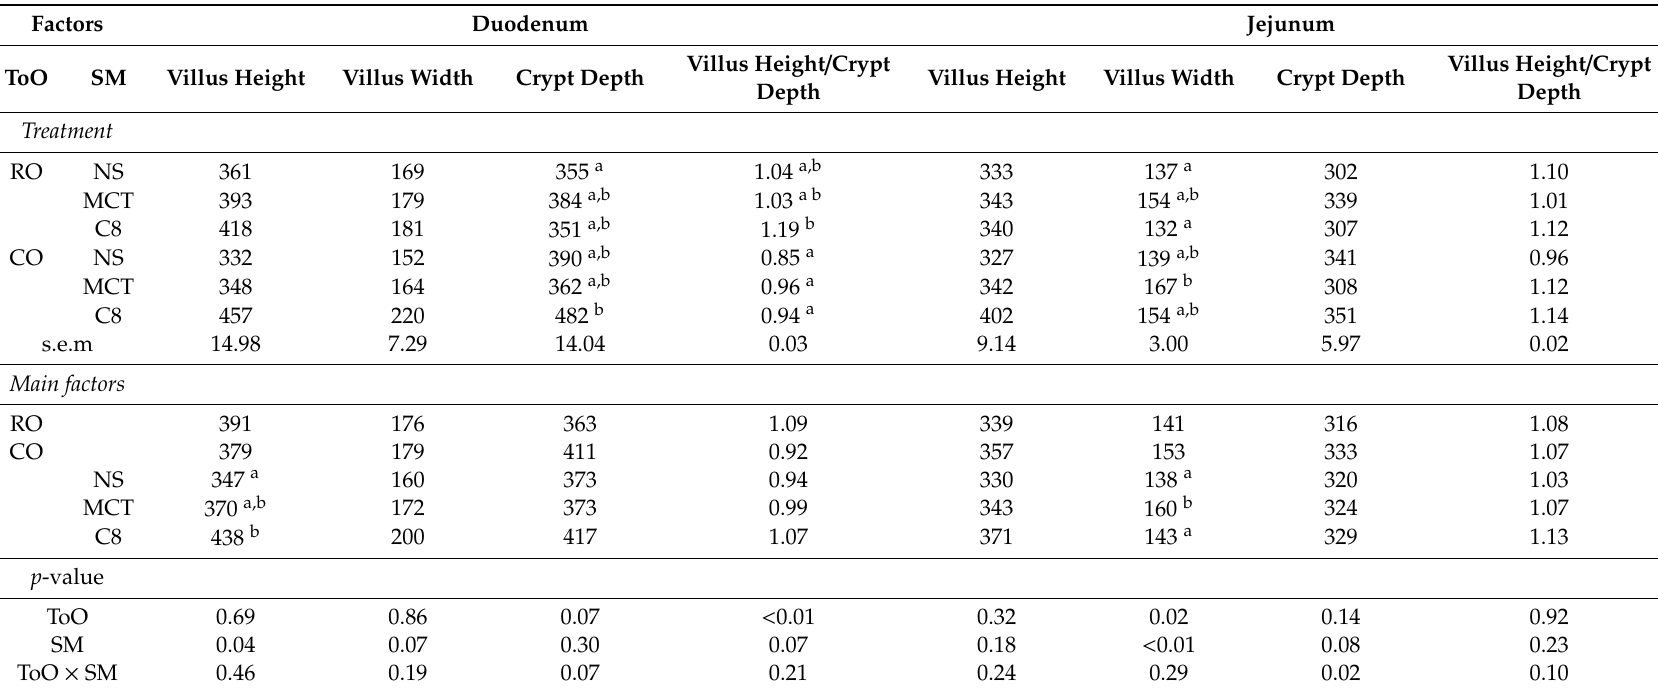
Table 9. Mucosal epithelium structure of the duodenum and jejunum ( µ m) of piglets at 60th day of